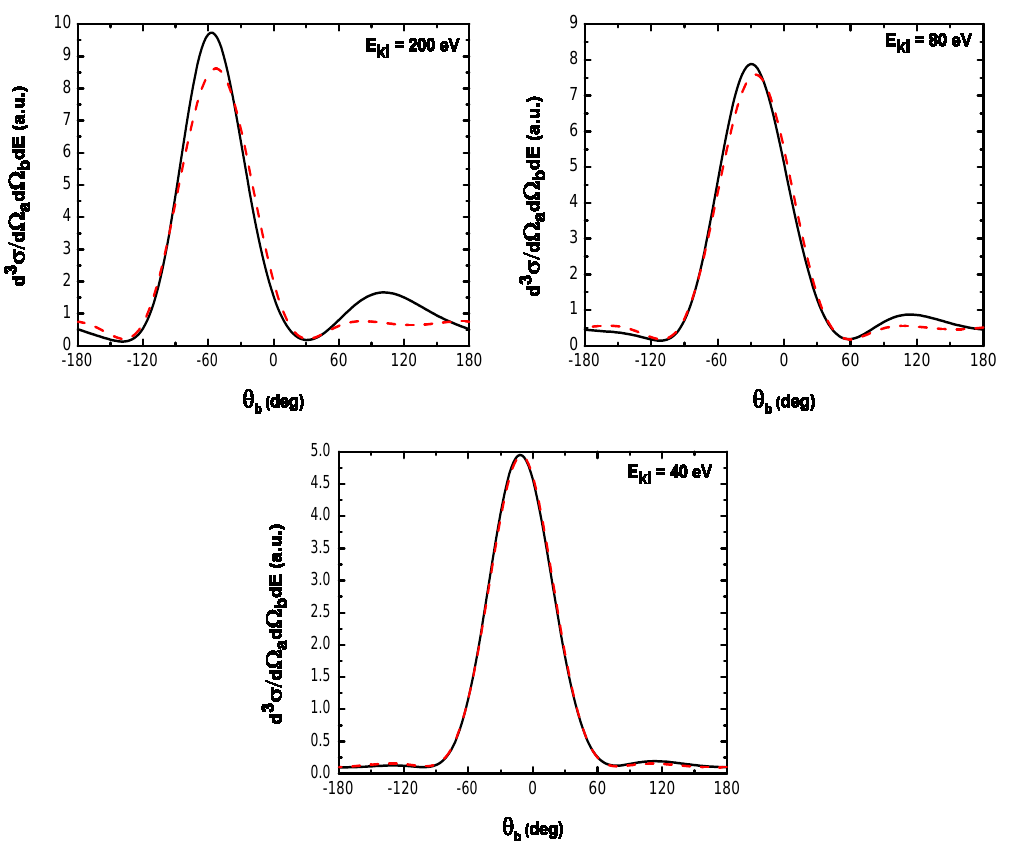
Figure 17. Triple differential cross sections corresponding to the laser-assisted electron-impact ionization process of atomic hydrogen as a function of the ejected angle θ b with no net exchange of photons ( (cid:96) = 0 ) and for different values of incident electron energy E k frequency is ω = 1.17 eV and the electric field strength is E 0 = 10 7 V/cm. The ejected electron energy = 5 eV, and the scattering angle is θ a = 4 ◦ . Solid lines: second Born approximation results is E k b where the laser polarization is parallel to the momentum transfer ( ˆ ε // ∆ ) . Dashed lines: second Born approximation results where the laser polarization is parallel to the incident momentum ( ˆ ε // k i )